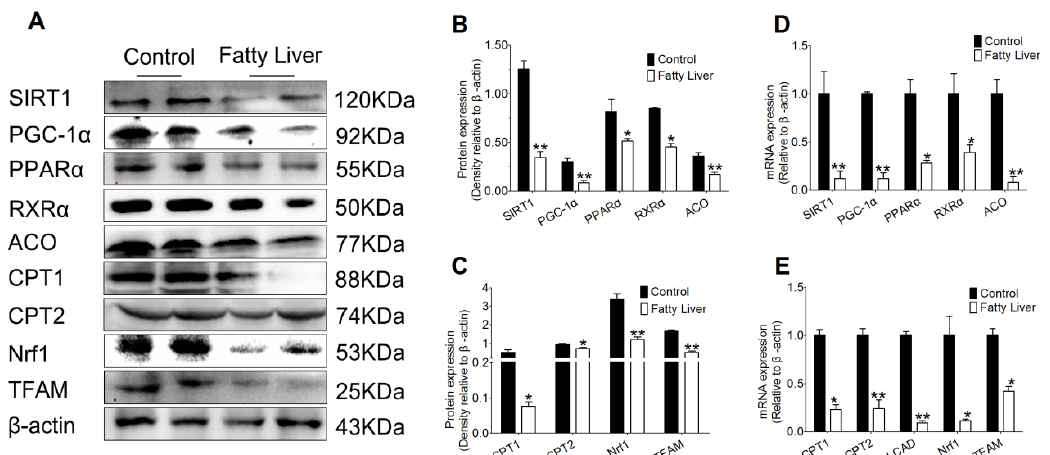
Figure 4. Lipid deposition hinders the fatty acid oxidation pathway in cow liver. ( A – C ) Levels of the protein levels of SIRT1, PGC-1 α , peroxisome proliferator-activated receptor alpha (PPAR α ), retinoid X receptor alpha (RXR α ), acyl coenzyme A oxidase (ACO), carnitine palmitoyltransferase 1 (CPT1), carnitine palmitoyltransferase 2 (CPT2), nuclear respiratory factor 1 (Nrf1) and transcription factor A (TFAM) in control (n = 6) and fatty liver (n = 6) group dairy cows were determined by western blotting. ( D , E ) Total RNA was extracted from liver samples and the expressions of genes involved in the fatty acid oxidation pathway in control (n = 6) and fatty liver (n = 6) group dairy cows were determined by real-time RT-PCR. The data presented are the mean ± SEM. * p < 0.05; ** p <